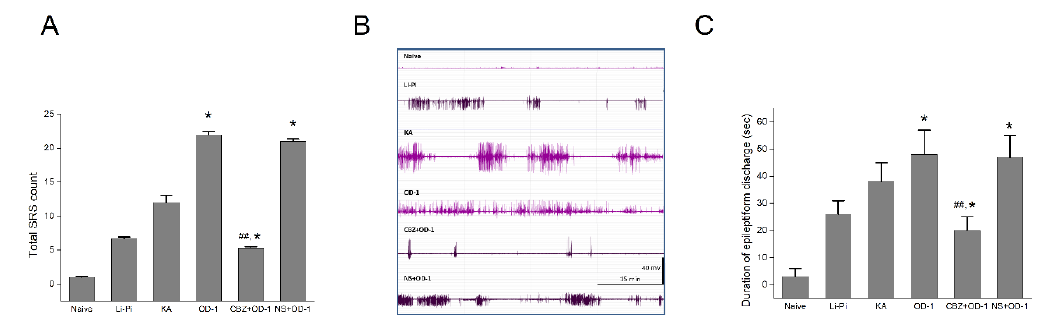
Figure 5. The spontaneous recurrent seizure (SRS) and epileptiform discharges on EEG during the chronic stage following status epilepticus. ( A ) The OD-1 group had a significantly higher total SRS count compared with the naïve, Li-Pi, KA (all * p < 0.05), and OD-1 + CBZ groups ( ## p < 0.01). The total SRS count in the KA group was higher than that in the OD-1 + CBZ group ( p < 0.05). The control group. ( B ) and ( C ) Representative figures of the epileptiform discharges on EEG showing that the high frequency epileptiform bursts in rats with SRS were more frequently seen in the OD-1 group and NS + OD-1 group compared with the naïve, Li-Pi, and KA groups (all * p < 0.05) and CBZ + OD-1 group ( ## p <